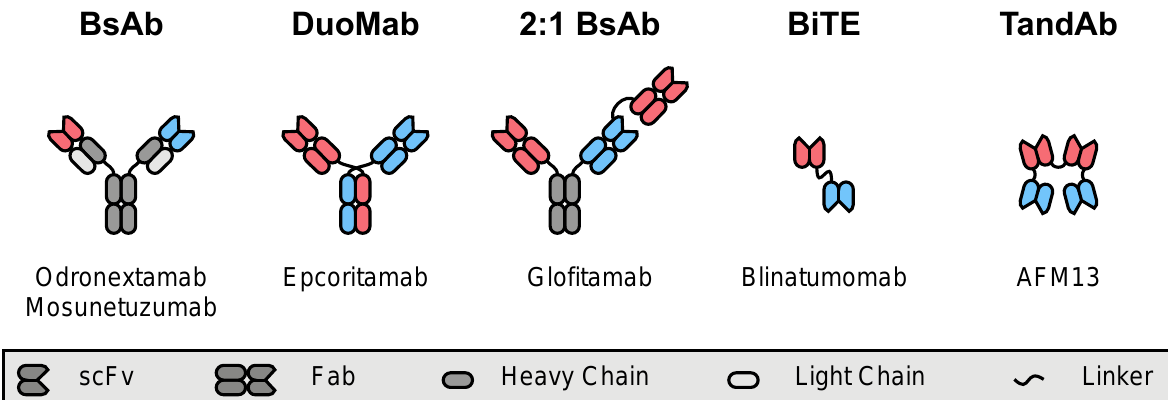
Figure 4. Multivalent antibody constructs for lymphoma immunotherapy. Numerous polyspecific antibody constructs with a range of binding valencies have been developed, and several formats are in advanced stages of development for lymphoma. Bispecific antibodies (BsAbs) are a very common format, with multiple derivatives, including DuoMabs and multivalent ligands incorporating additional antigen-binding fragments (Fabs). Bispecific T-cell engagers (BiTEs) and tandem diabodies (TandAbs) are physically smaller targeting ligands based on the careful fusion and folding of single-chain variable fragments (scFvs). Here, red and blue elements distinguish scaffold components that correlate with binding to two distinct target